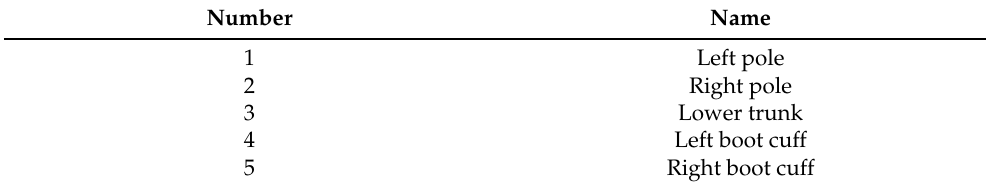
Figure 1. Sensors reference system. Table 1. Reference number of each sensor.